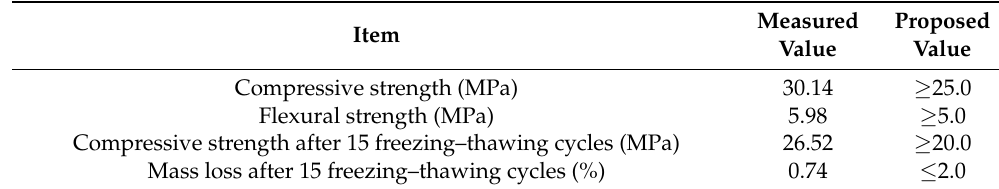
Table 4. Mechanical and freezing resistance properties of autoclaved bricks according to the calculated aggregate gradation and optimum autoclave system.